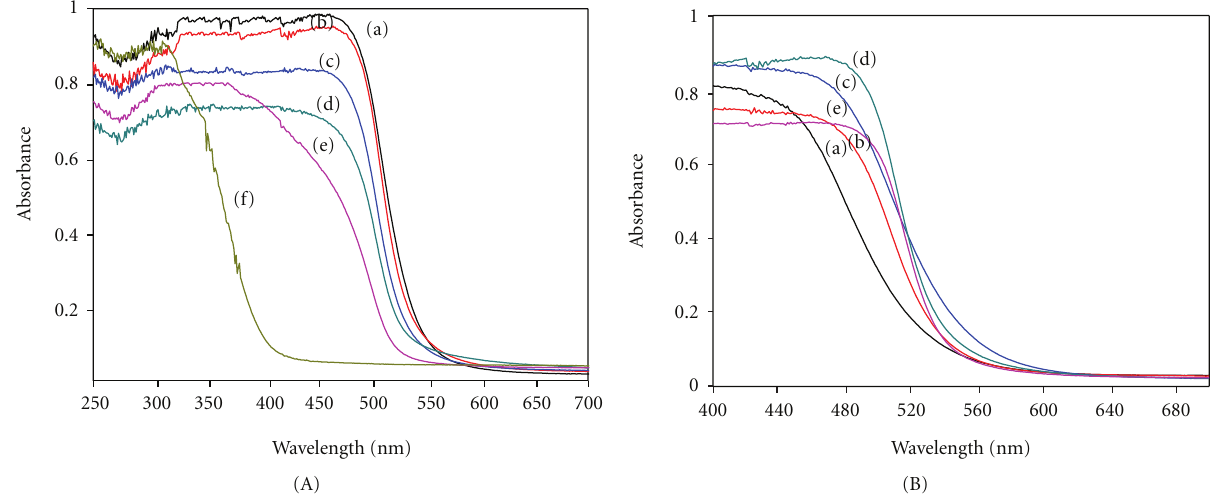
Figure 5: UV-Vis DRS spectra of Cd 1 − x Zn x S / SiO 2 with di ff erent composition (A): (a) x = 0, (b) x = 0.2, (c) x = 0.4, (d) x = 0.6, (e) x = 0.8, and (f) x = 1 and of Cd 0 . 8 Zn 0 . 2 S/SiO 2 sample calcined at di ff erent temperature (B): (a) 393K, (b) 623K, (c) 673 K, (d) 723K, and (e) 773